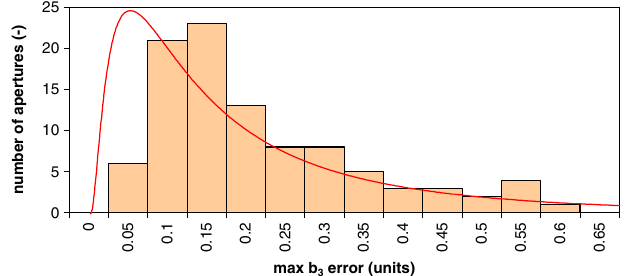
FIG. 10. (Color) The histogram and log-normal distribution of the difference between the sextupole snap-back amplitudes and the correlation line.